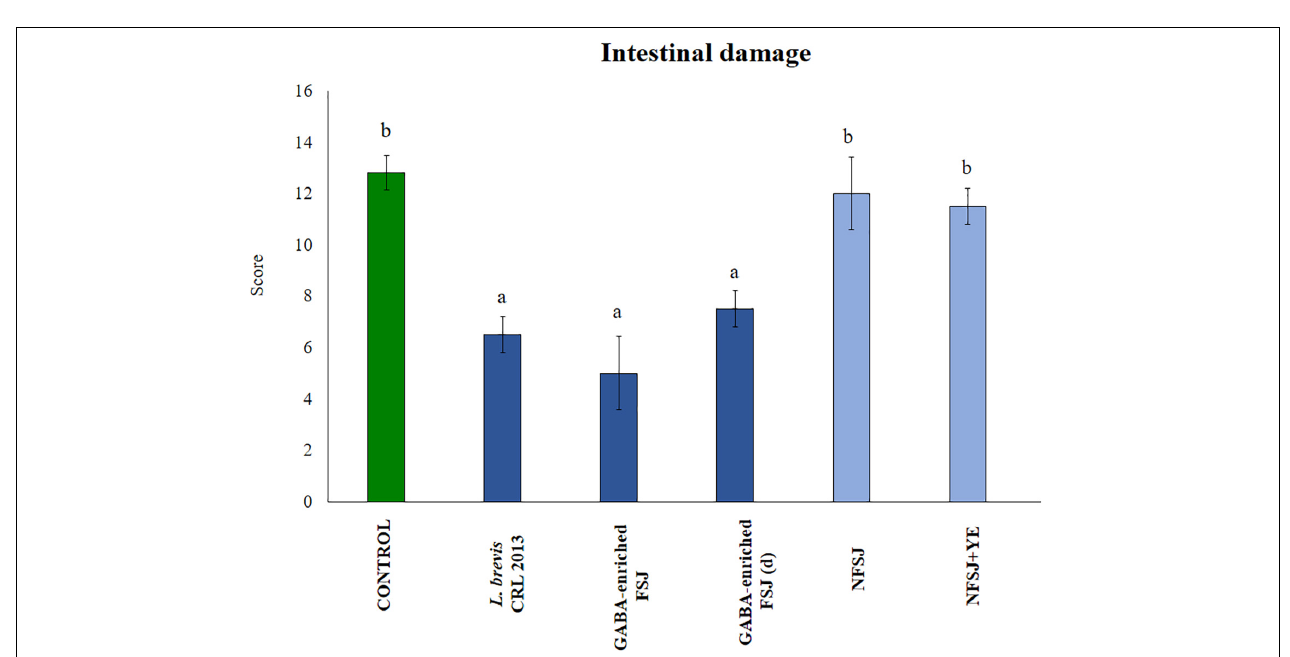
FIGURE 7 | Effect of L. brevis CRL 2013, GABA-enriched strawberry fermented juice (FSJ) and diluted (d) GABA-enriched FSJ on intestinal damage in mice challenged with LPS. Animals treated with NFSJ or NFSJ supplemented with YE were used for comparisons. Score values were calculated considering the presence/absence and intensity of edema, epithelial injury, degranulation of Paneth cells and inflammation. Results are expressed as mean ± SD. Means for each bar without a common letter differ significantly. Significance with Tukey’s HSD post hoc test following a one-way ANOVA is indicated as p < 0.05.